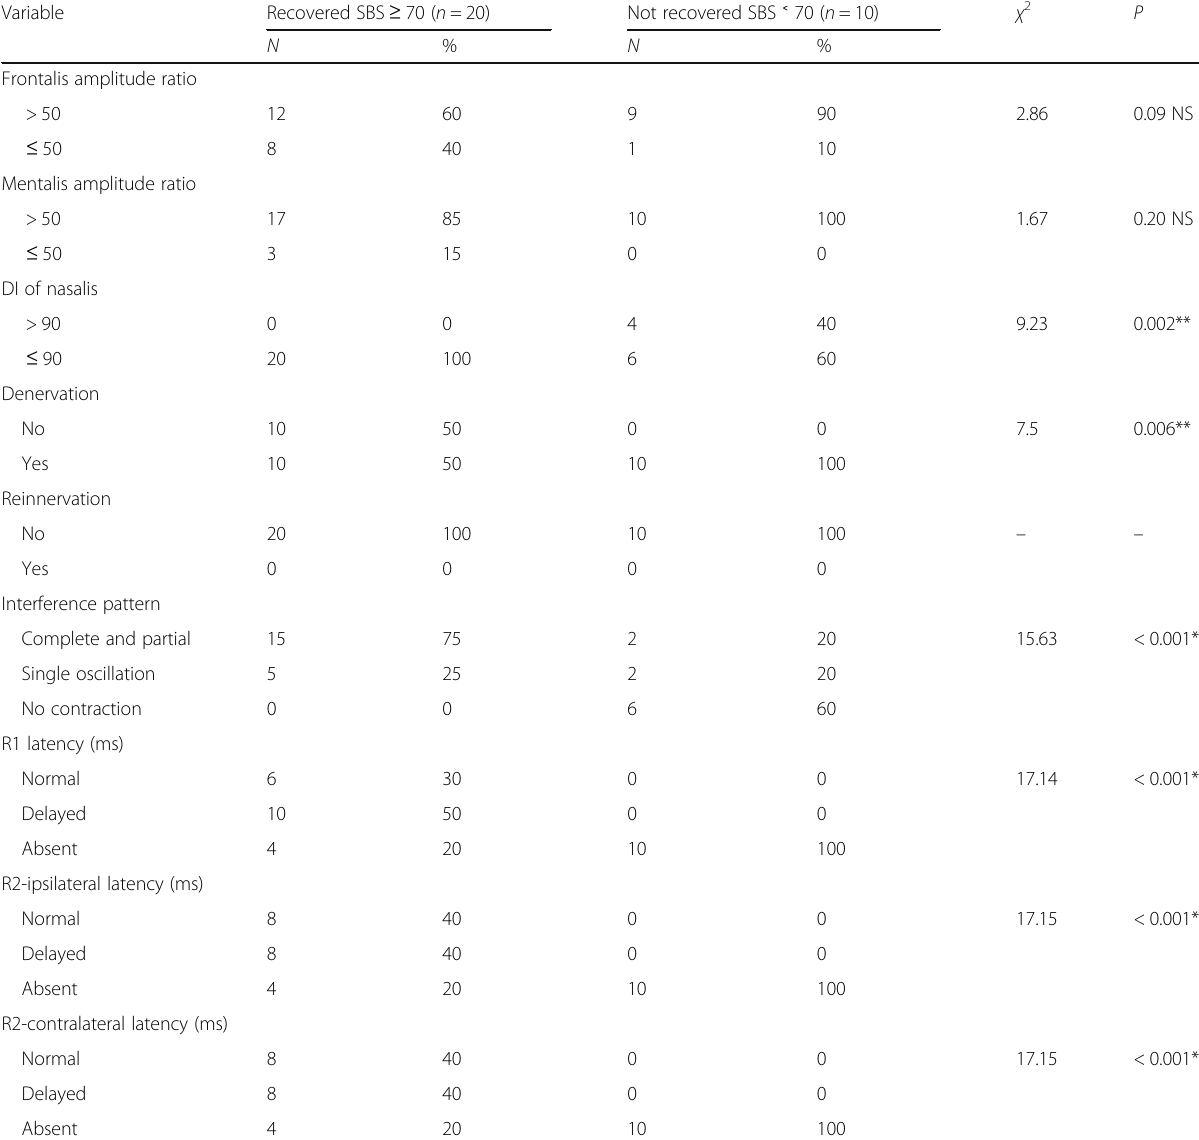
Table 3 Relationship between electrophysiological data and recovery at 1 month according to Sunnybrook score (SBS)